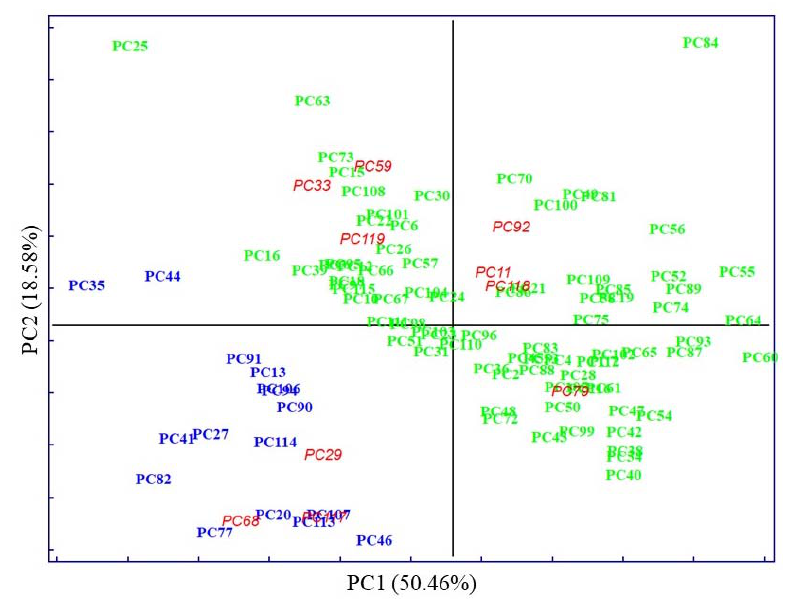
Figure 2. Scores for the plasma samples on the first two principal components explaining the varia ‐ bility in the dataset of five measured clinal parameters. The samples are labelled according to their specific pathology: no MetS ( ), MetS ( ), and external test samples ( ).